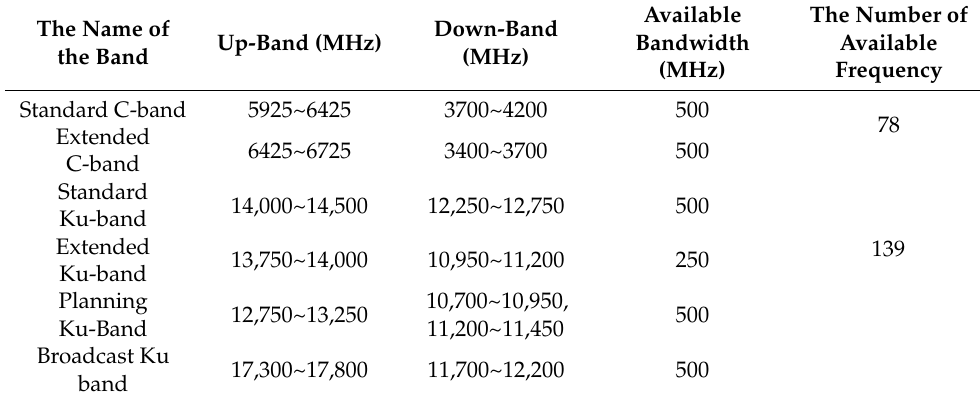
Table 1. Frequency band and the number of available frequency